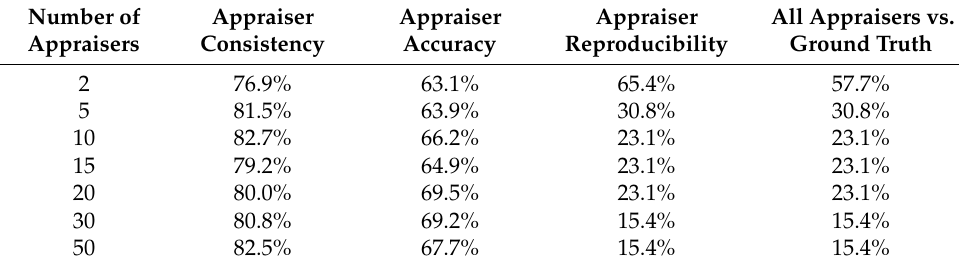
Table 6. Repeated AAA with varying appraiser